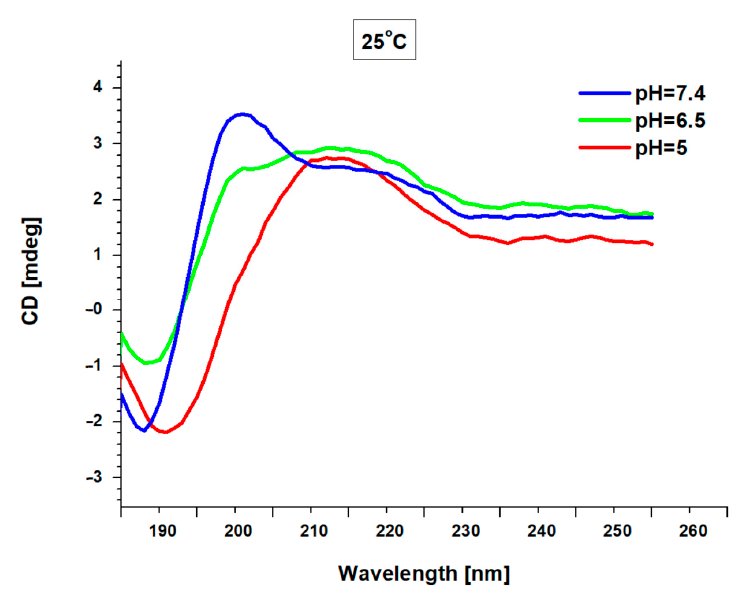
Figure 15. Circular Dichroism (CD) of PLL 78 – b – (PLL 10 – g – PHIS 15 ) as a function of pH.